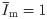
Contour plots of the effect of the presence of SMCs in the SES on the cost function for paclitaxel (left column) and sirolimus (right column) over the design space consisting of initial concentration in the stent polymer
c
0 and release time
t
E.The scale for the cost function representation is truncated at a maximum of 1; all values larger than 1 are colored black. The green contour line traces I¯m=1, the yellow contour line T¯m=1, and the red contour line T¯e=1. The horizontal axis at the top of the plot marks the time points of 1 (h)our, 1 (d)ay, 1 (w)eek, 1 (m)onth and 1 (y)ear. Gray dots indicate evaluated designs. Optimization cases A: paclitaxel release and B: sirolimus release with SES SMC density corresponding to 1% of the medial SMC density. C: Paclitaxel release and D: sirolimus release with SES SMC density corresponding to 5% of the medial SMC density. E: Paclitaxel release and F: sirolimus release with SES SMC density corresponding to 25% of the medial SMC density.